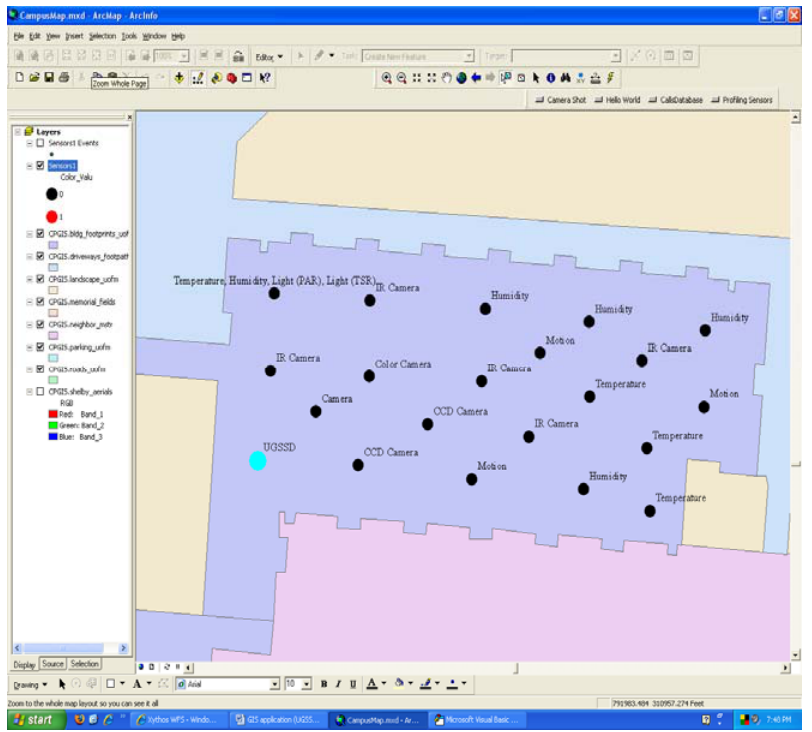
Figure 3. Inside plant view: Area of interest within the engineering sciences building with a heterogeneous sensor deployment. One UGSSD is highlighted in the lower left of the